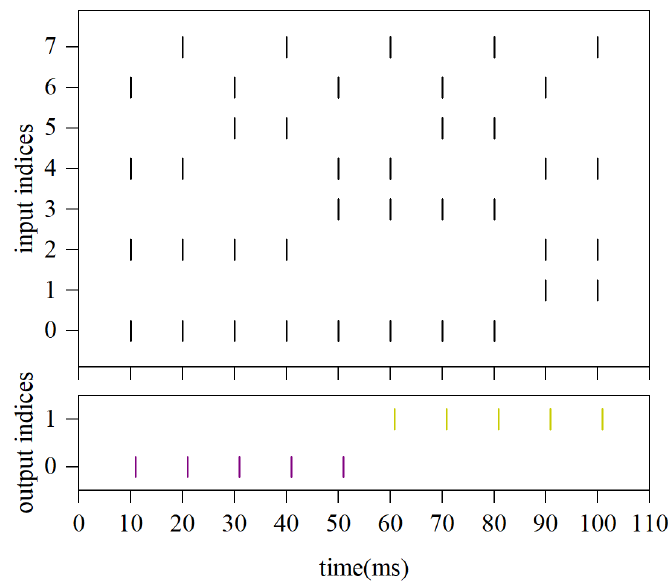
Figure 10. The test results of the 8421-BCD code rounding logic